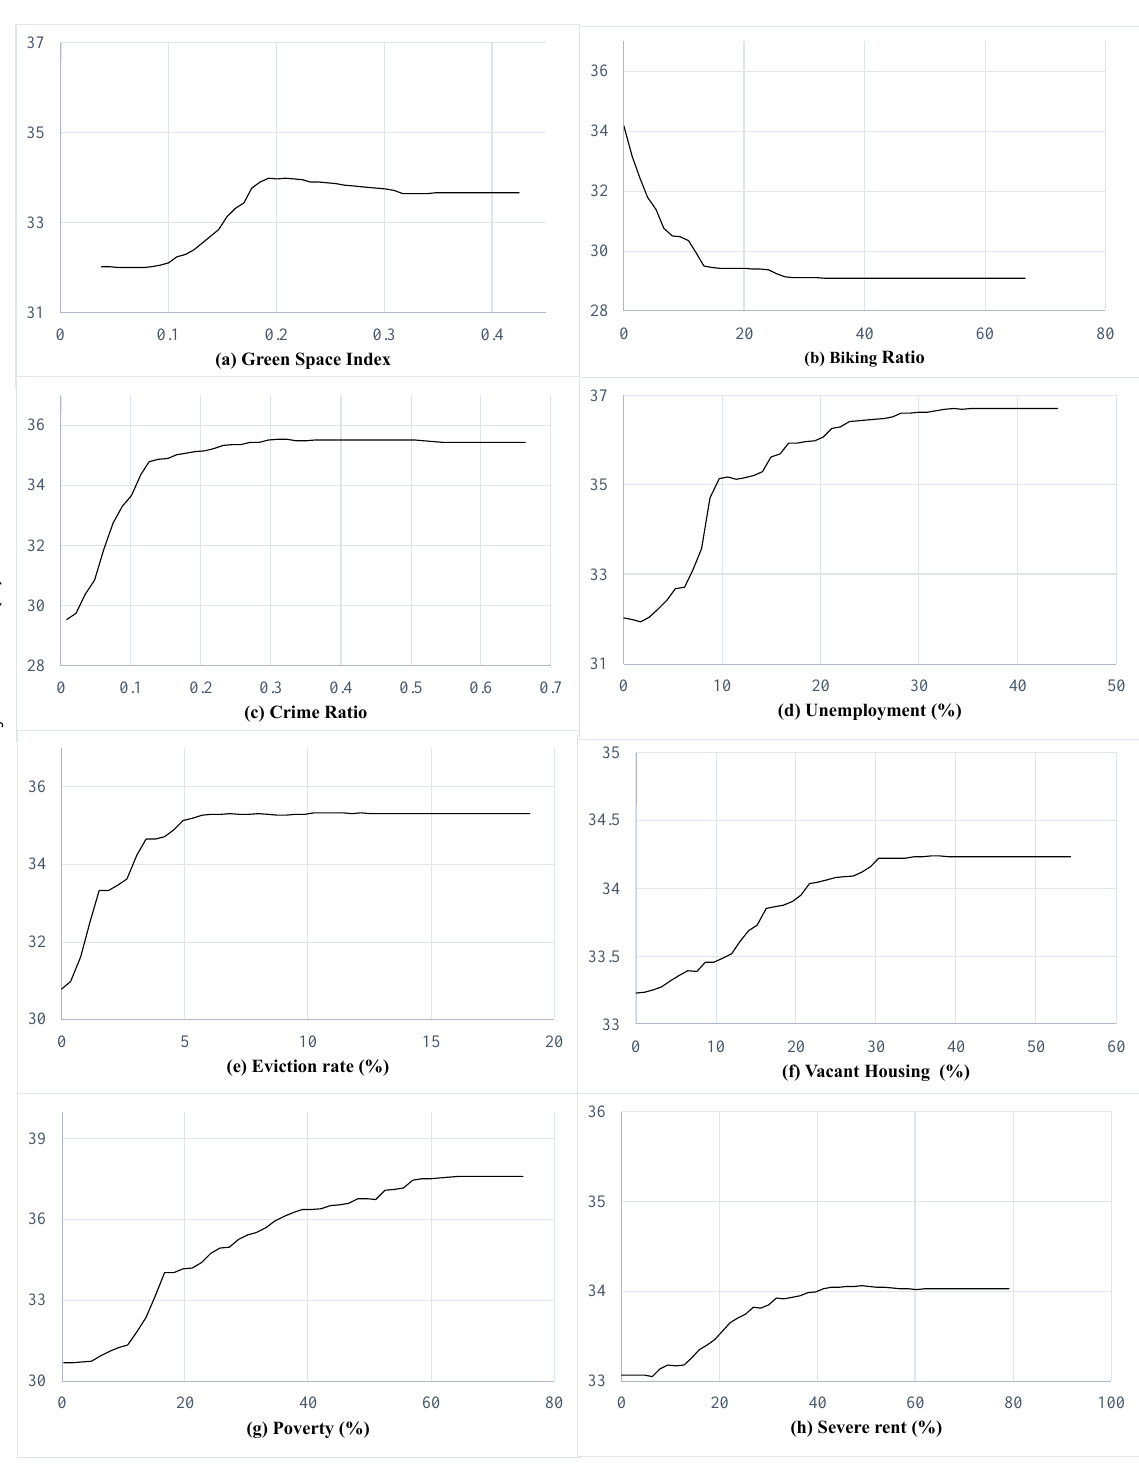
Figure 2. Partial dependency plots of the determinants of the global random forest.